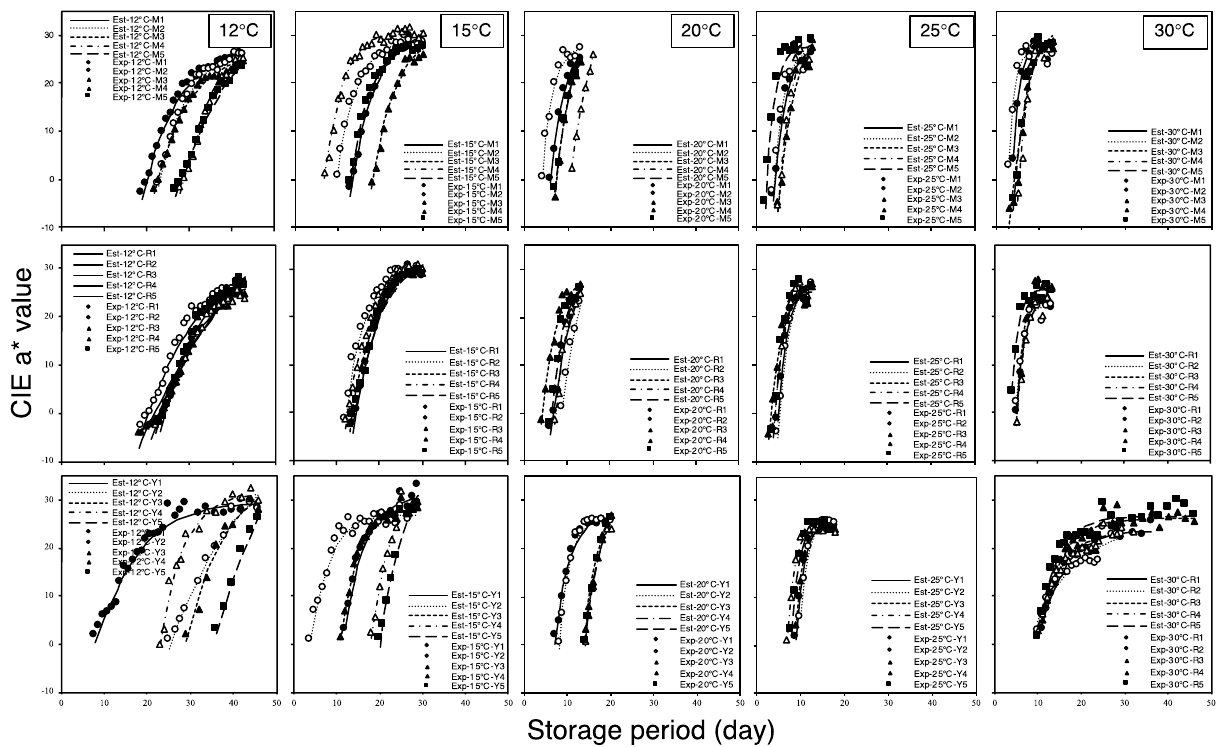
sigmoid-type function